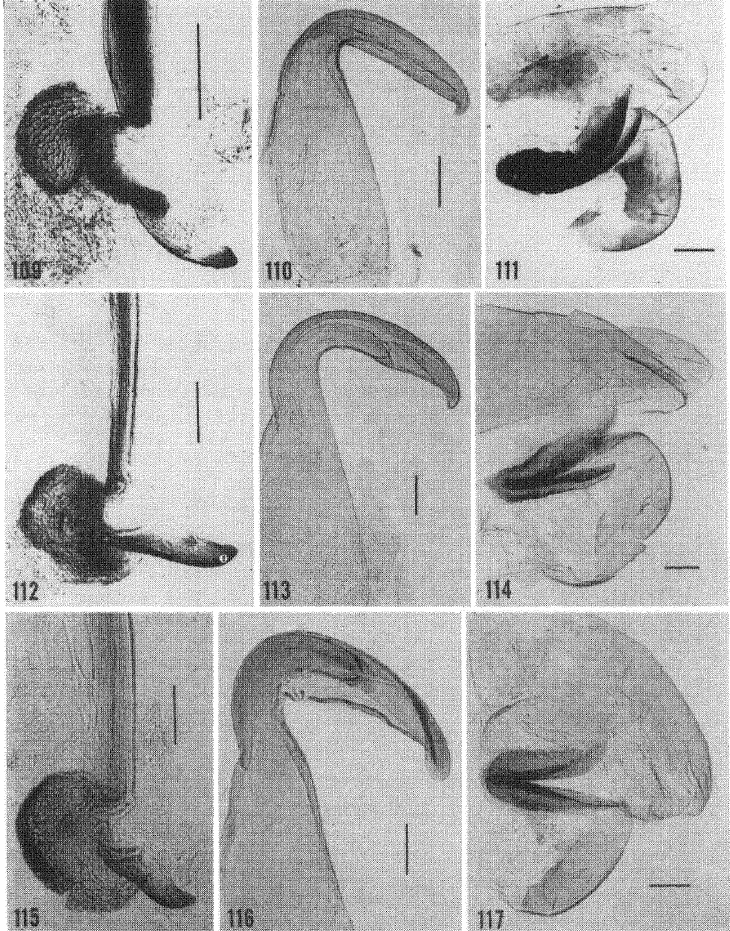
Figures 109-117. Male genital phallomeres of Cyrtotria spp. 109-111. (992 L). G. allicornis (from shown in Fig. 108). 112-114. (55 CUZM). C. tuberculata. Fsiolo, Kenya (det. Prineis). 115-117. (56 CUZM). C. orientalis (from shown in Fig. 103). (scale--0.1